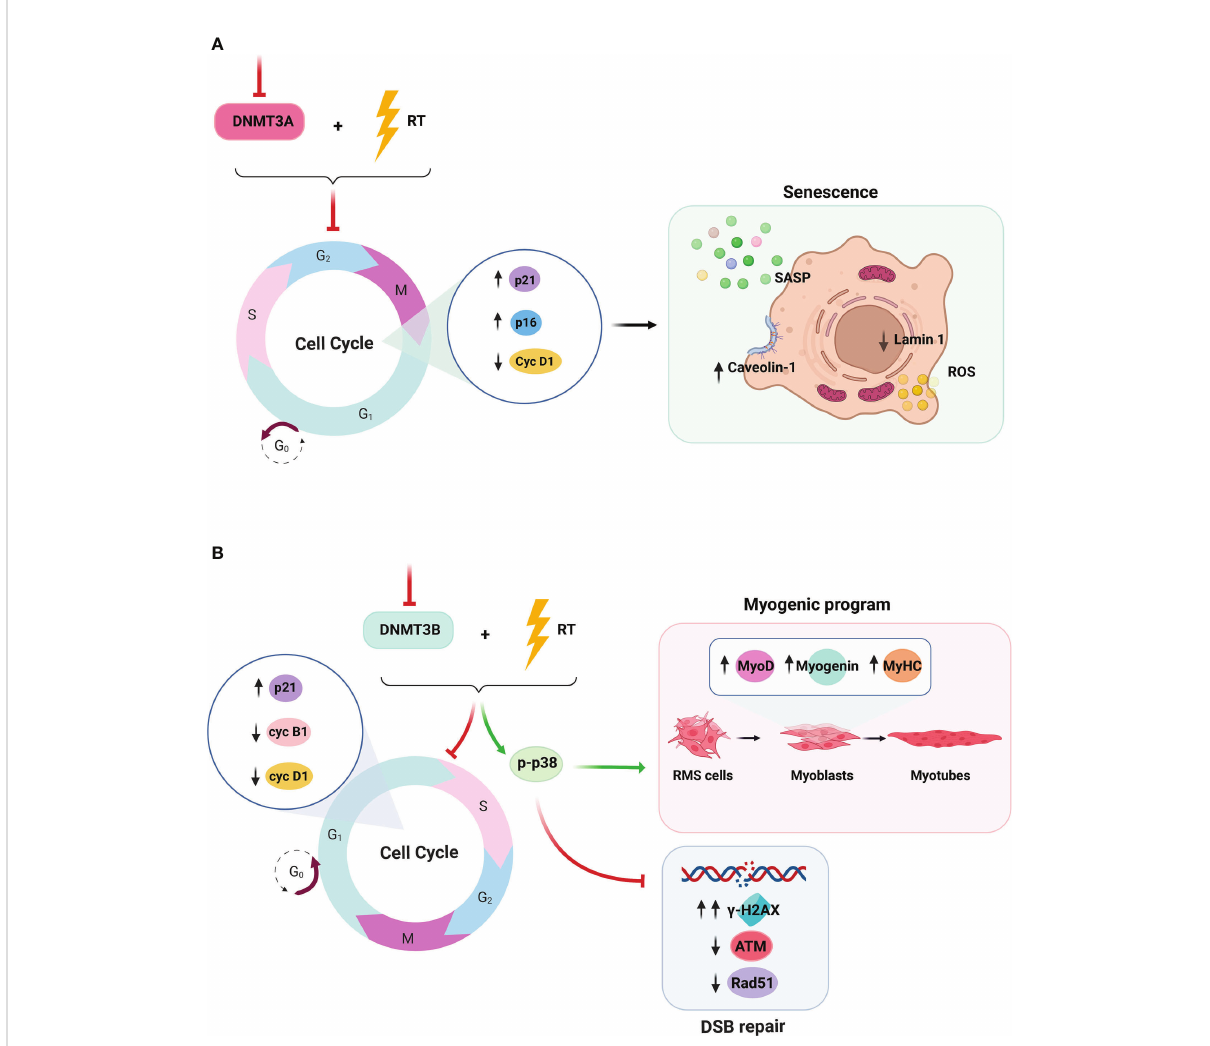
FIGURE 4 Effects of the combined treatment with DNMT3A/3B silencing and radiotherapy. Visual representation of the different radiosensitizing mechanisms observed upon (A) DNMT3A and (B) DNMT3B knocking down and RT